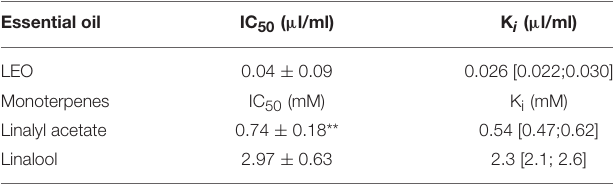
FIGURE 1 | Percentage of 3 H-Citalopram binding induced by different concentrations of linalool on the SERT assay. Linalyl acetate did not show affinity to the serotonin transporter (data not shown). *** p < 0.0001 vs. the lowest concentration tested.